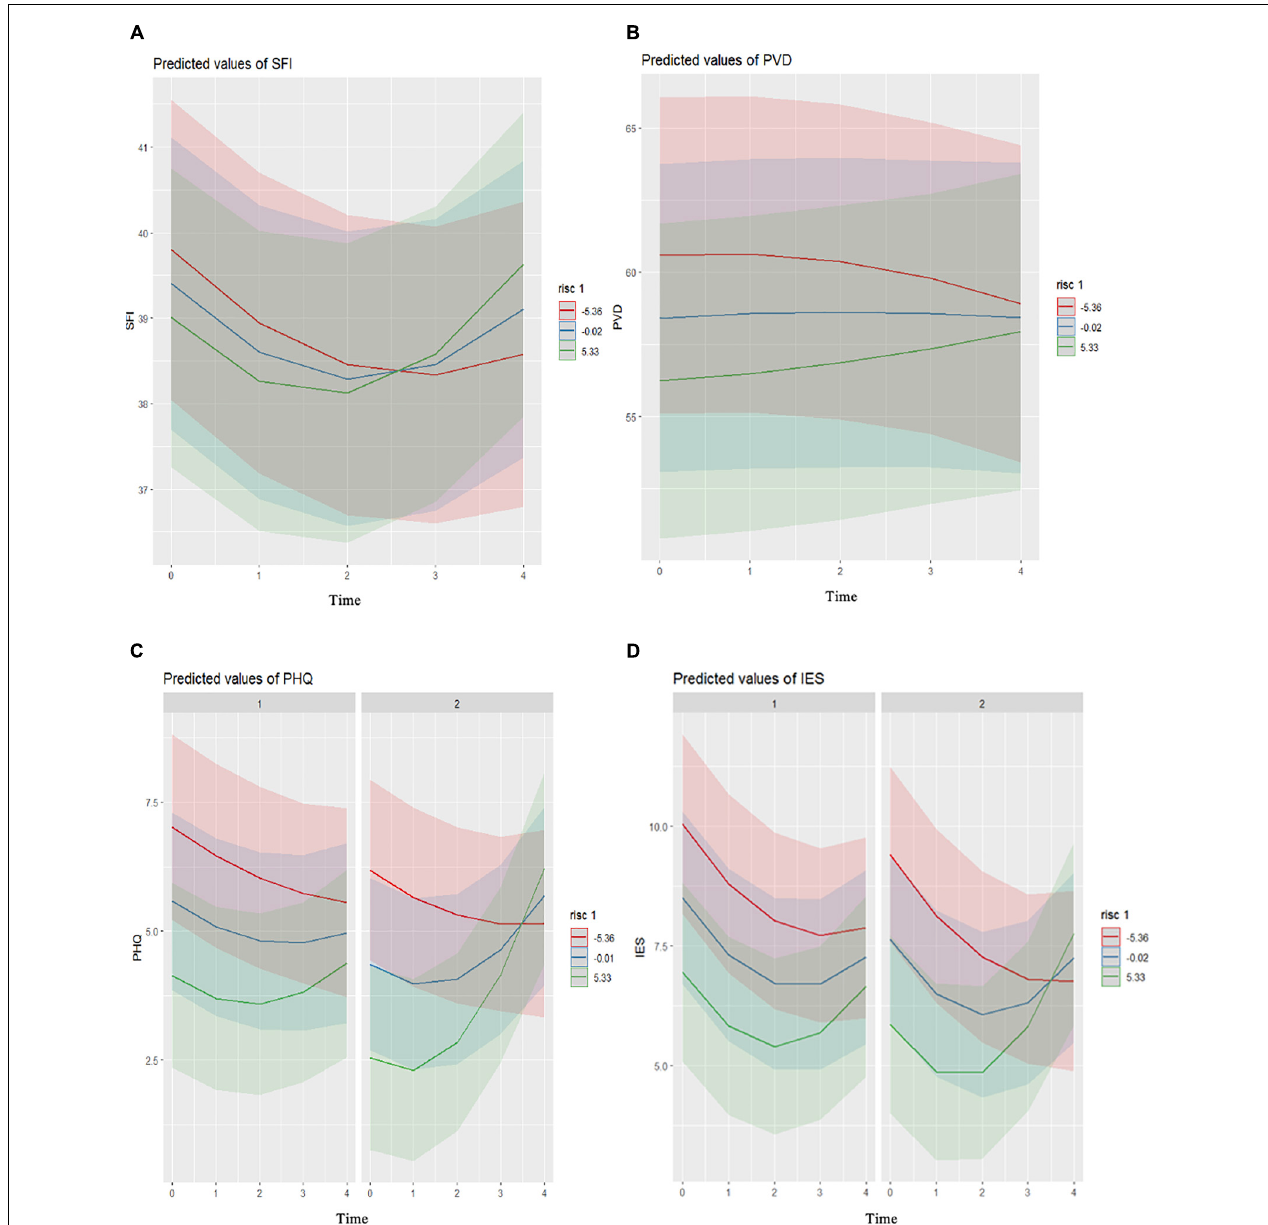
FIGURE 2 | Trajectories of the mental health of the healthcare professionals across the five measurement points for their resilience levels (red, –1SD; blue, mean; green, + 1SD). Slopes of COVID-19–related anxiety (A) , perceived vulnerability (B) , depressiveness (C) , and psychological trauma symptomatology (D) , all by Resilience levels. According to front-line (c1,d1) and second-line (c2,d2) healthcare professionals. Time: 0, April 2020; 1, July 2020; 2, October 2020; 3, January 2021; 4, April 2021. S.F.I., Swine Influenza Anxiety Index; PVD, Perceived Vulnerability to Disease Scale; PHQ, Patient Health Questionnaire; IES, Impact of Event Scale; RISC, Connor-Davidson Resilience